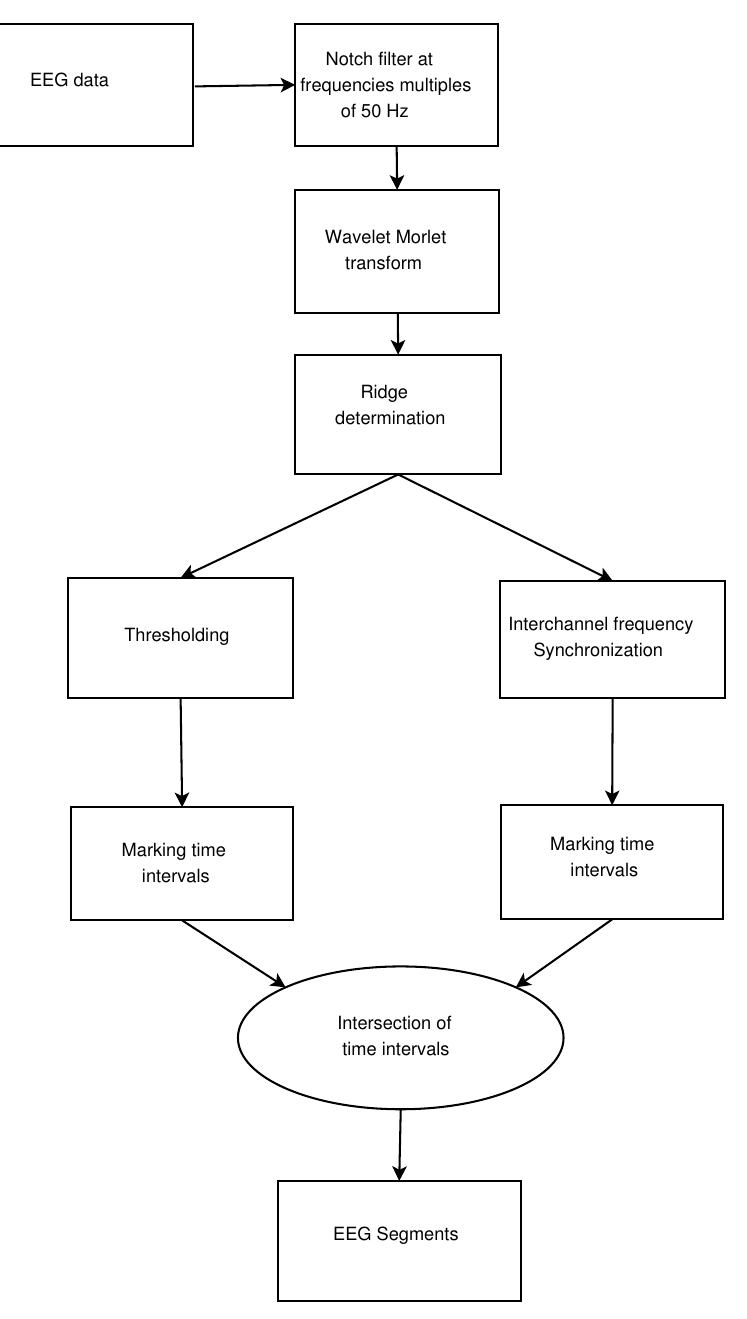
Figure 1. Block diagram of a long-term EEG segmentation. Let us show how segmentation was carried out using the example of an EEG recording fragment containing an ES. For each EEG channel, we calculated the wavelet spectrogram (2) and the ridges of the wavelet spectrogram (17) in frequency range [0.5; 22] Hz. Generalized ESs were characterized by changes in power in several EEG channels and the synchronization of different channels pairs. In order to estimate the inter-channel synchronization, the modulus of the frequency difference at the points of the ridges was calculated for each pair of channels. If the modulus of the difference was less than ε , then there was synchronization Sync i , j , otherwise, it was